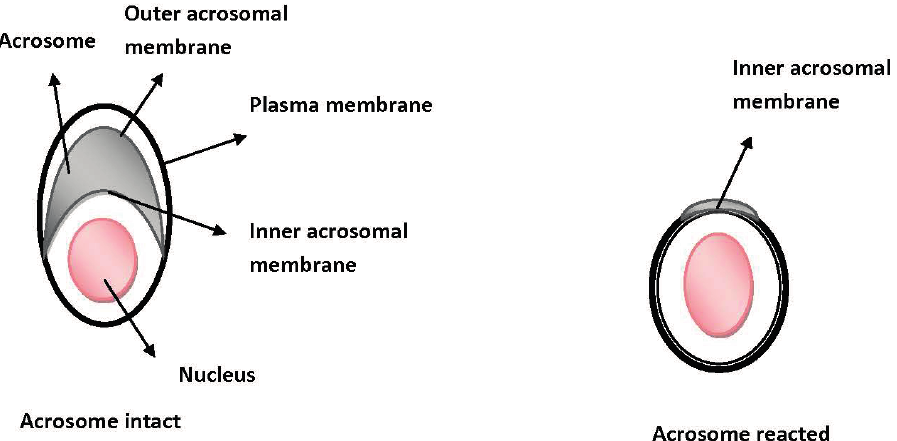
Figure 3. The process where an acrosome intact spermatozoon becomes acrosome-reacted. It is believed that the acrosome intact spermatozoa reach the ZP. The latter and especially ZP3 has been proposed to promote the acrosome reaction. Following binding, the outer acrosomal membrane fuses with the sperm plasma membrane for the acrosomal